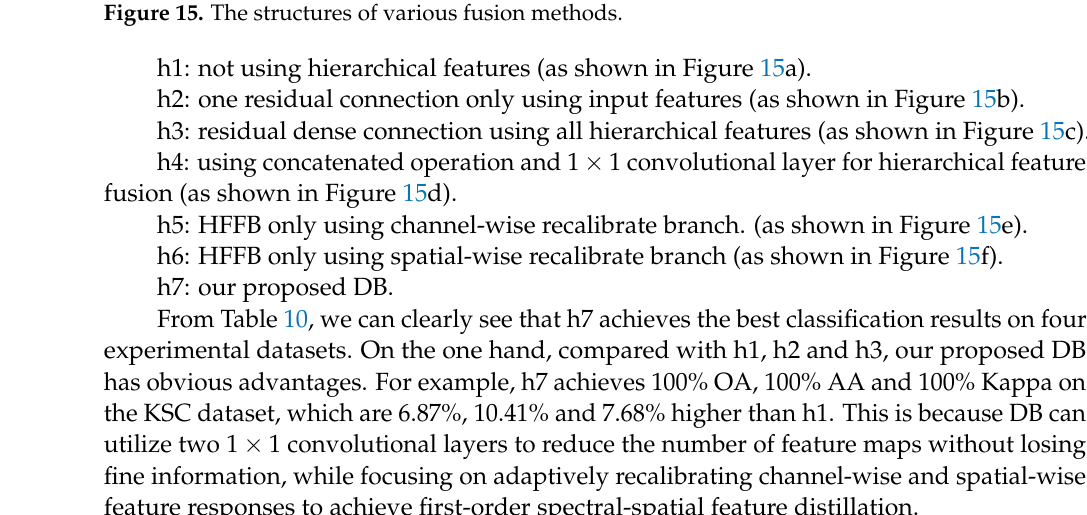
Figure 15. The structures of various fusion